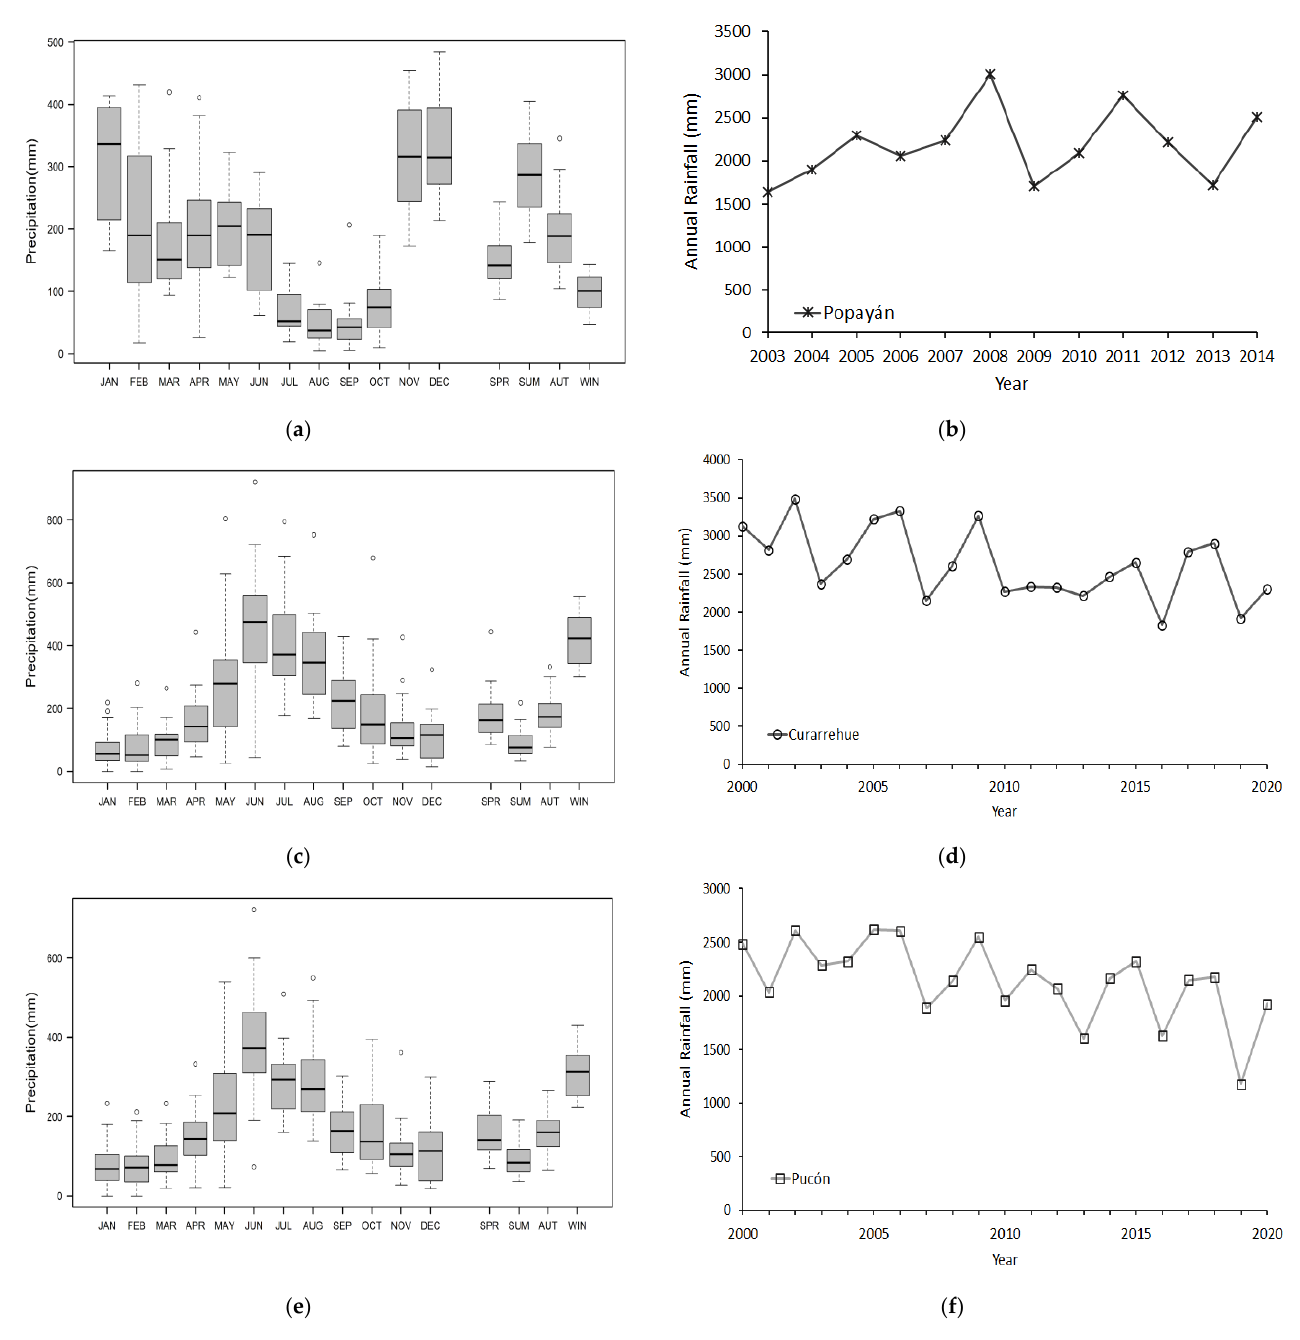
Figure 2. Box-plot for monthly mean precipitation ( a , c , e ), and total annual ( b , d , f ) for the period 2003 – 2014 for the towns of Popayán, Colombia, and the period 2000 – 2020 for Curarrehue and Pucón, Chile. Table 2. Descriptive statistics of trends in annual precipitation (mm) between 2000 and 2020.